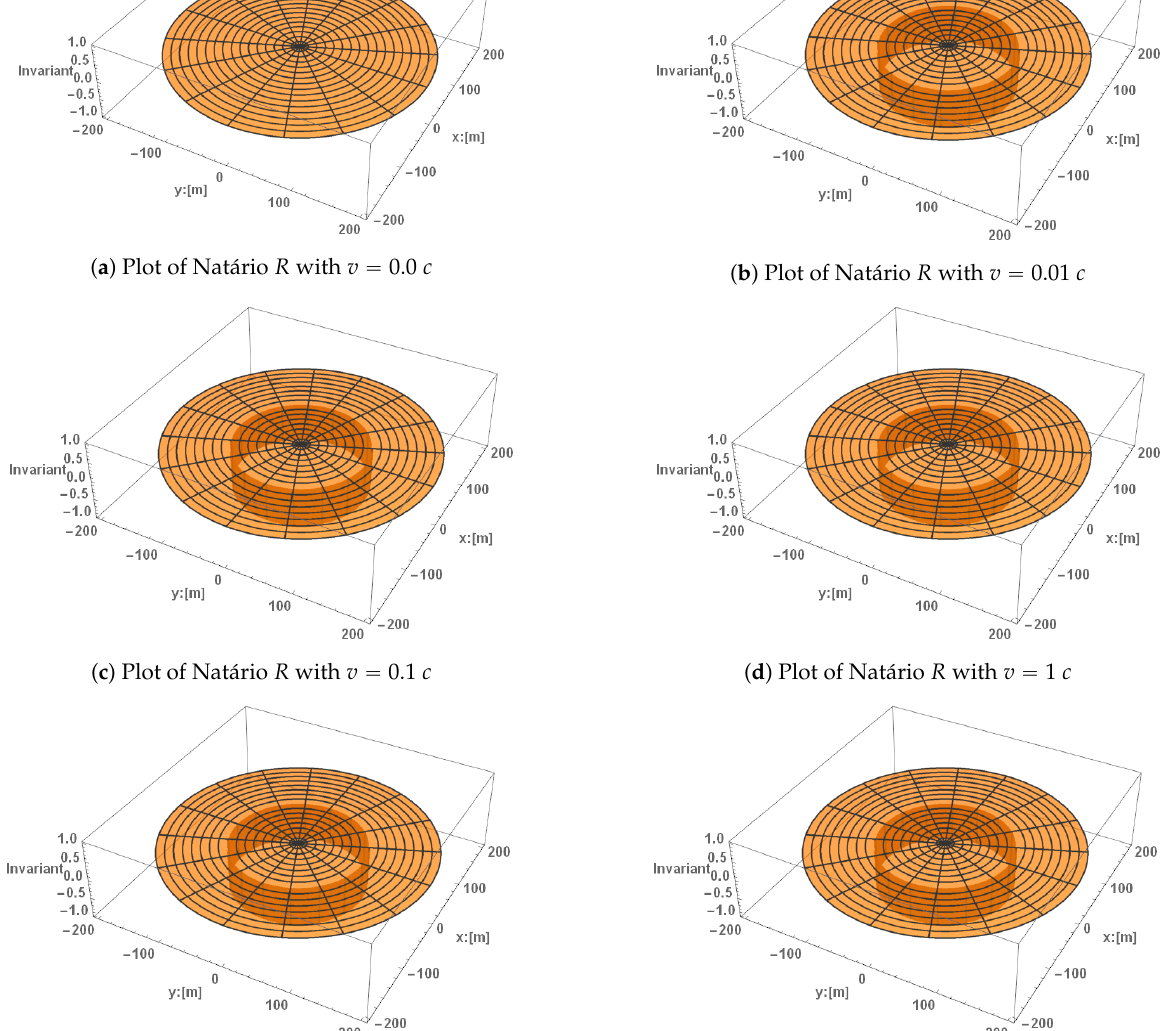
Figure 4. Velocity evolution of R, the Ricci scalar for the Natário warp drive at a constant velocity. The other parameters are set to σ = 50,000 1 and ρ = 100 m. Equation (11) is in natural units, so the speed of light was normalized out of the equation. m The factor of c was included in these captions to stress that the plots are of multiples of the speed of light. Their units are ms ´ 1